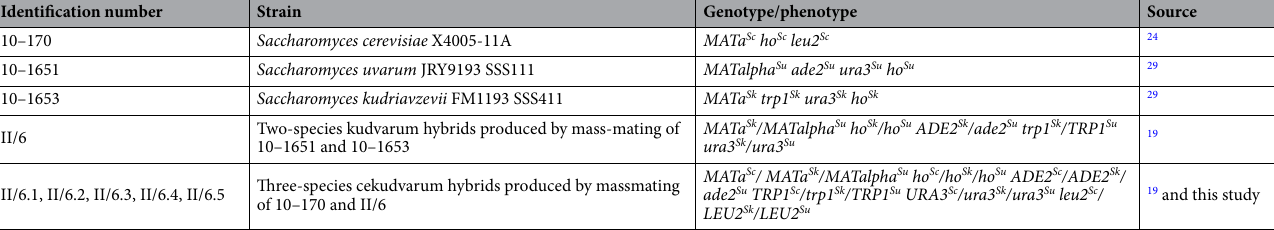
Table 1. List of